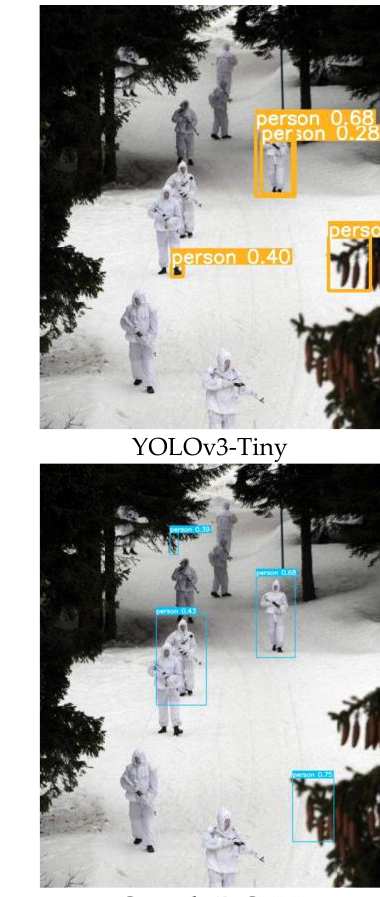
Figure 6. Snow scene visualization detection results.